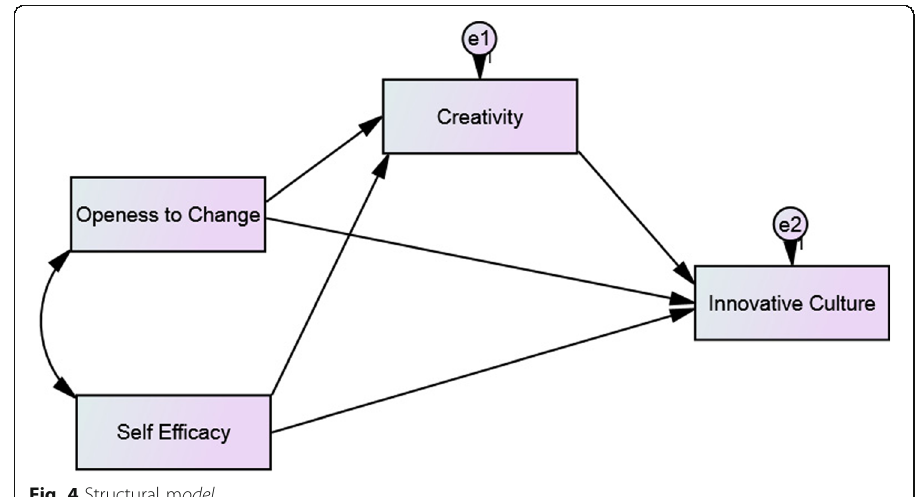
Fig. 4 Structural m odel